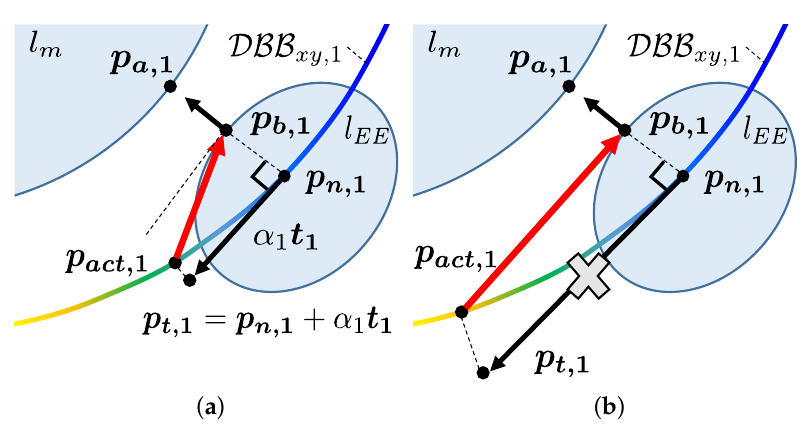
Figure 8. Illustration of finding the acting point. ( a ) The acting point on the DBB is selected as the closest to the point p n ,1 which is translated along the tangential direction t 1 with a step size α 1 ; ( b ) with a large step size, the generated force may not have a component along the direction connecting the closest point on the manipulator and